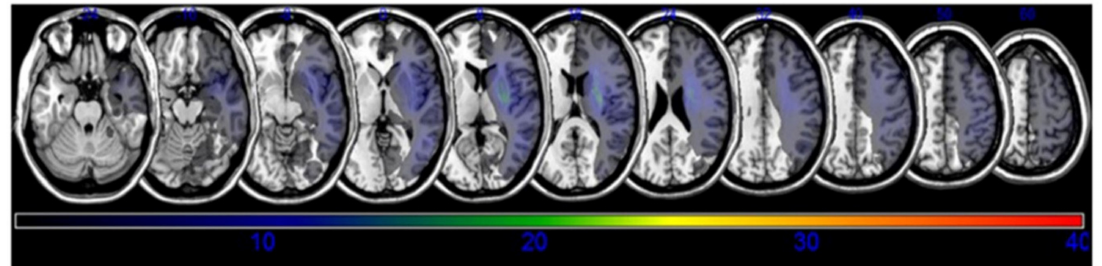
Figure 1. Overlay of lesions for stroke patients included in this study ( n = 39). Maps are overlaid on a